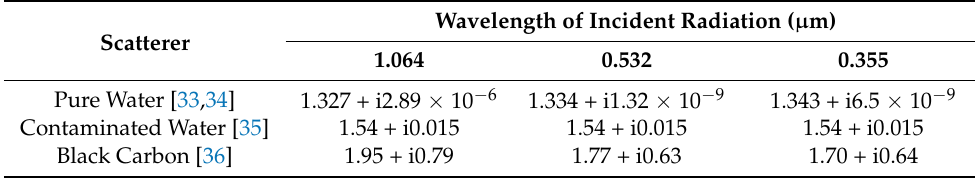
Table 1. Complex refractive index of contaminated water and black carbon at the 1.064, 0.532, and 0.355 µ m wavelengths of the incident radiation.